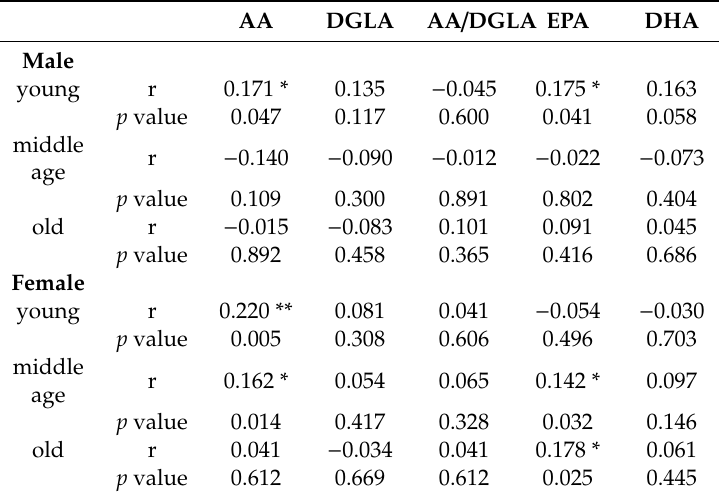
Table 2. Relationship between BROS and PUFAs (Correlation coe ffi